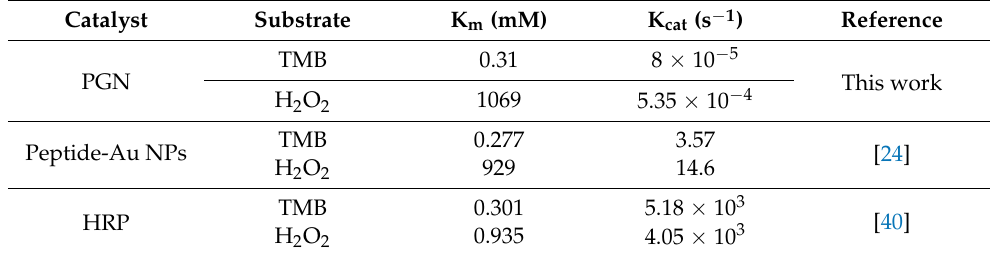
Figure 5. Steady−state kinetic assay and catalytic mechanism of the as−synthesized PGN towards various components: ( a , b ) 1 mM TMB and different concentrations of H 2 O 2 ; ( c , d ) 100 mM H 2 O 2 and different concentrations of TMB. Table 1. Comparison of kinetic parameters of K m and K cat of PGN, and HRP.